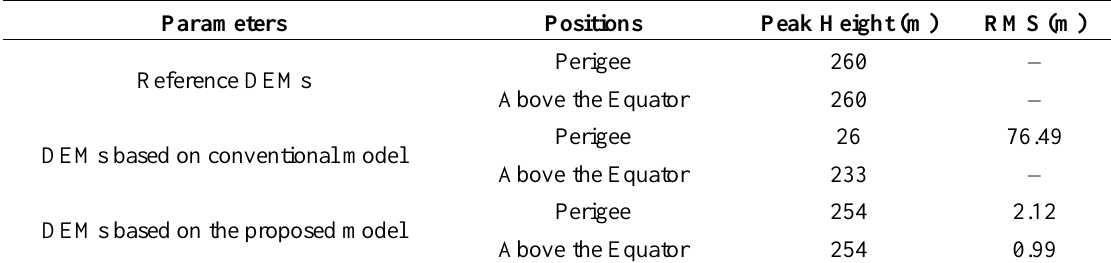
Figure 11. Error maps of the generated DEMs based on the GEO InSAR height retrieval model. ( a ) At perigee; ( b ) above the Equator. Table 7. Error analysis of the